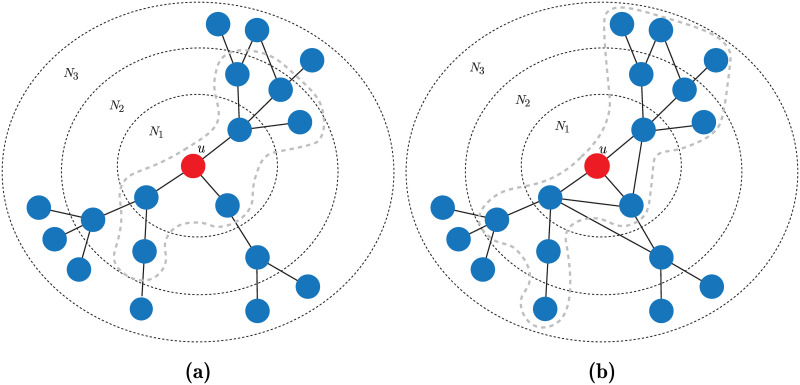
Illustration of the conditions of Assumption 1 (except the first condition).The boundary indicates the cell V(u). (a) Scenario where conditions 2, 3 and 4 are satisfied, and (b) scenario where neither condition is satisfied.